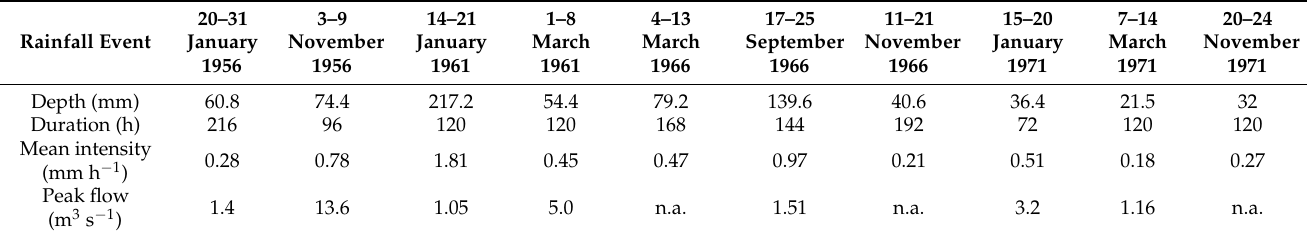
Table 2. Rainfall depth, duration, and intensity for the 10 selected events occurred at the Cittanova rain gauging station (Calabria, Southern